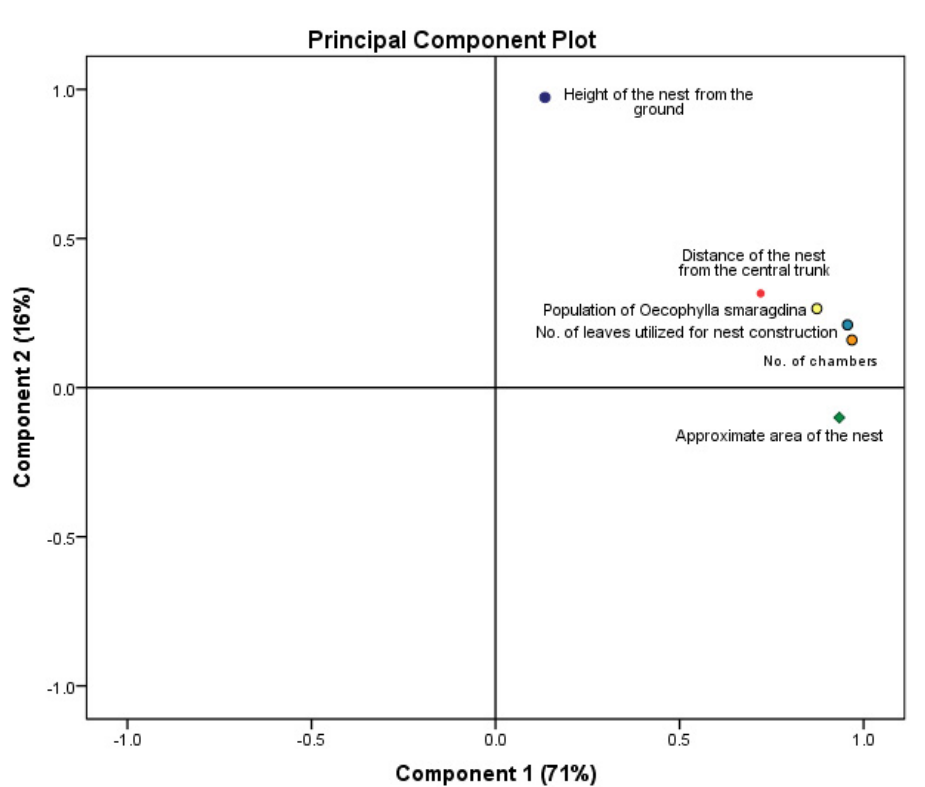
Fig 4 . Principal Component plot showing important factors contributing to variations in O. smaragdina nest size. Component 1 explaining about 71% variation and component 2 about